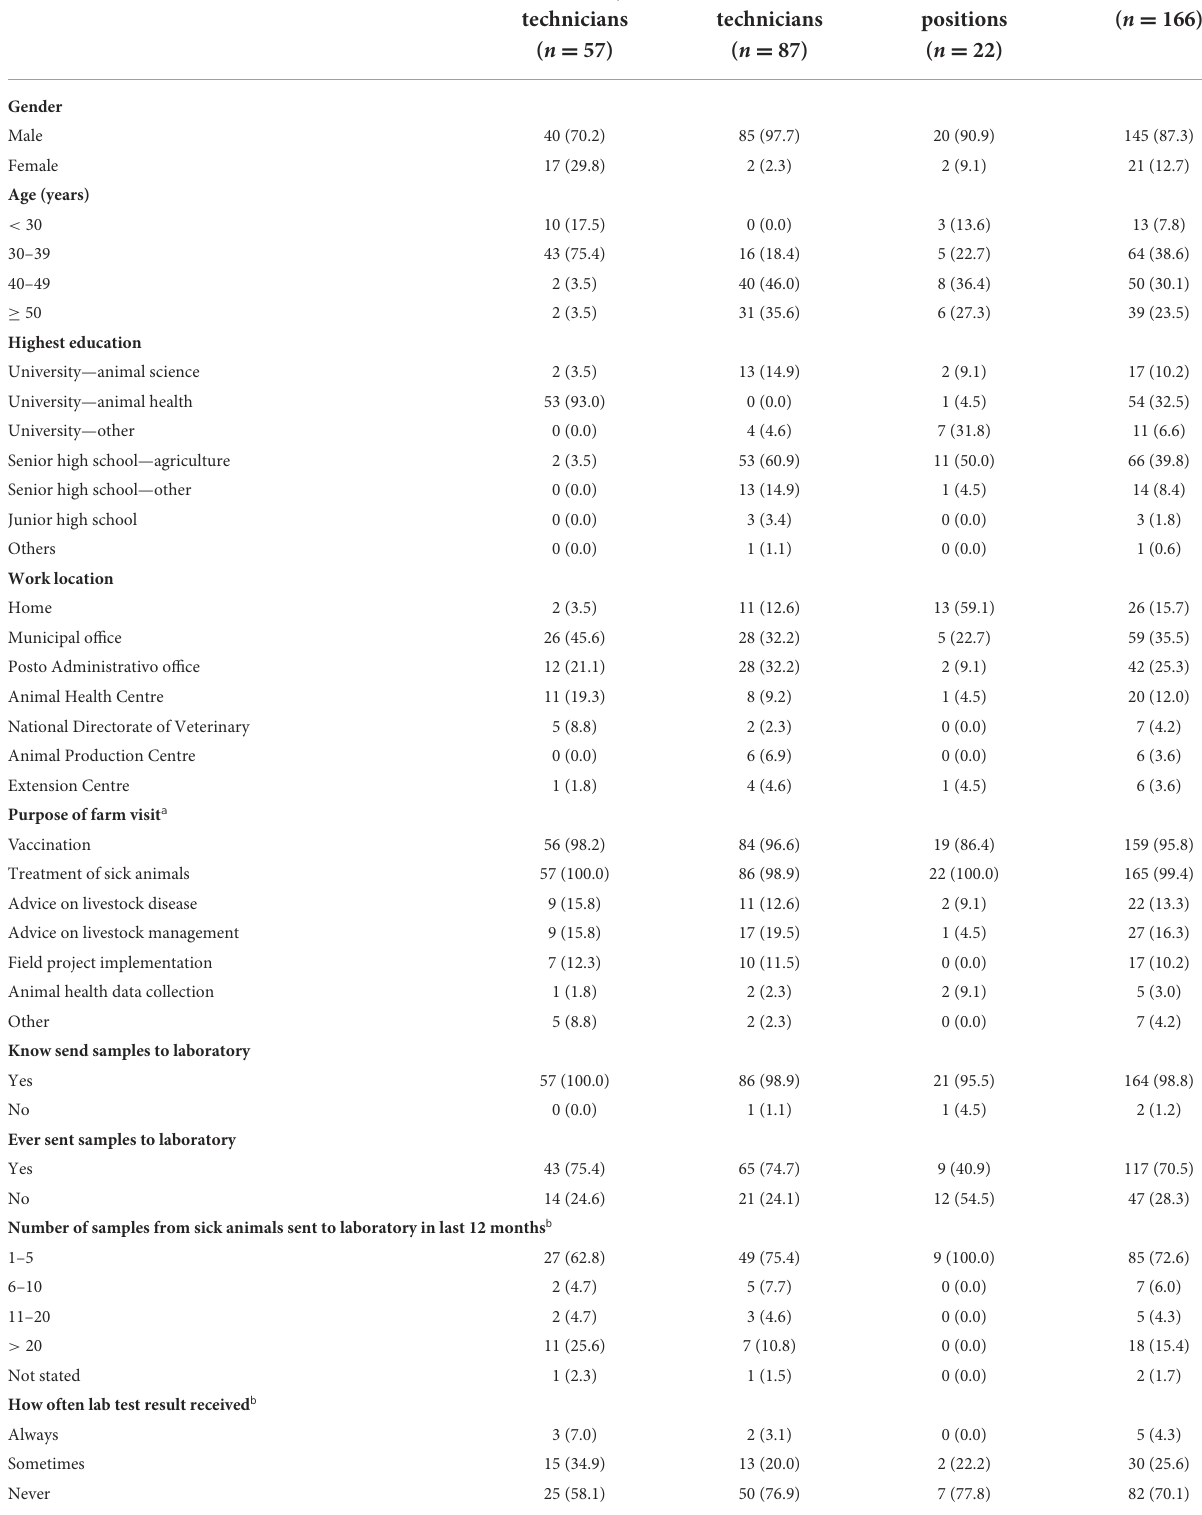
TABLE 1 Demographic information of 166 government animal health workers (overall and by position) surveyed in